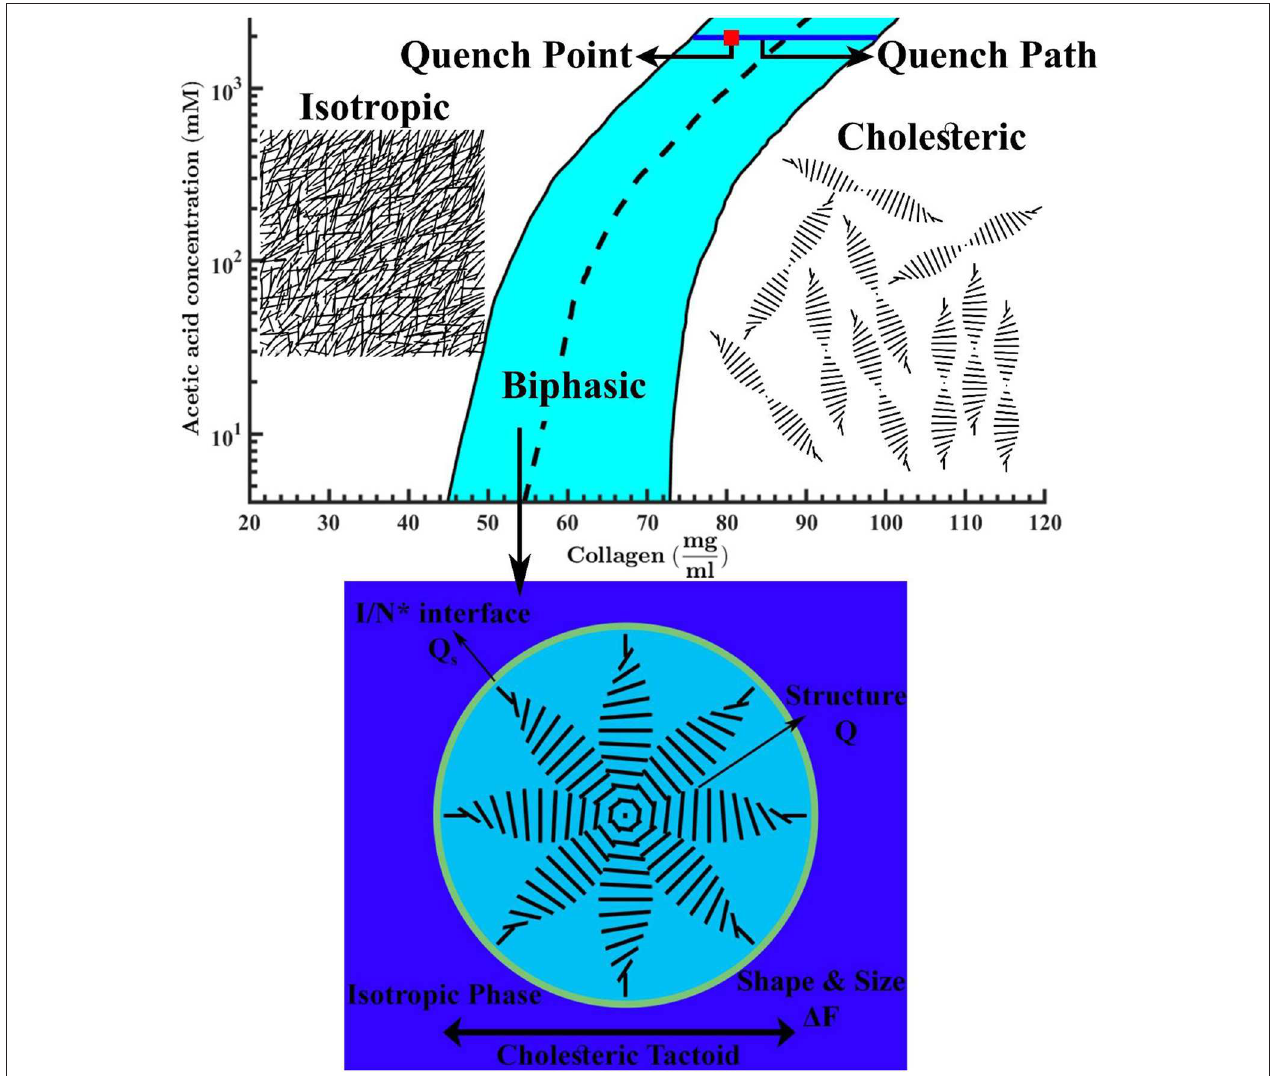
FIGURE 1 | Phase diagram of tropocollagen in acidic aqueous solutions. The black solid lines are binodal curves and the black dashed line is phase transition boundary. The quench point and the evolution path are shown by a red square and a blue solid line, respectively. This figure is adapted from Khadem and Rey [20]. The schematics denote the isotropic phase at low collagen concentrations, a typical micron-sized cholesteric drop in an isotropic bulk at intermediate concentrations, and the chiral nematic (N*) or cholesteric phase at higher